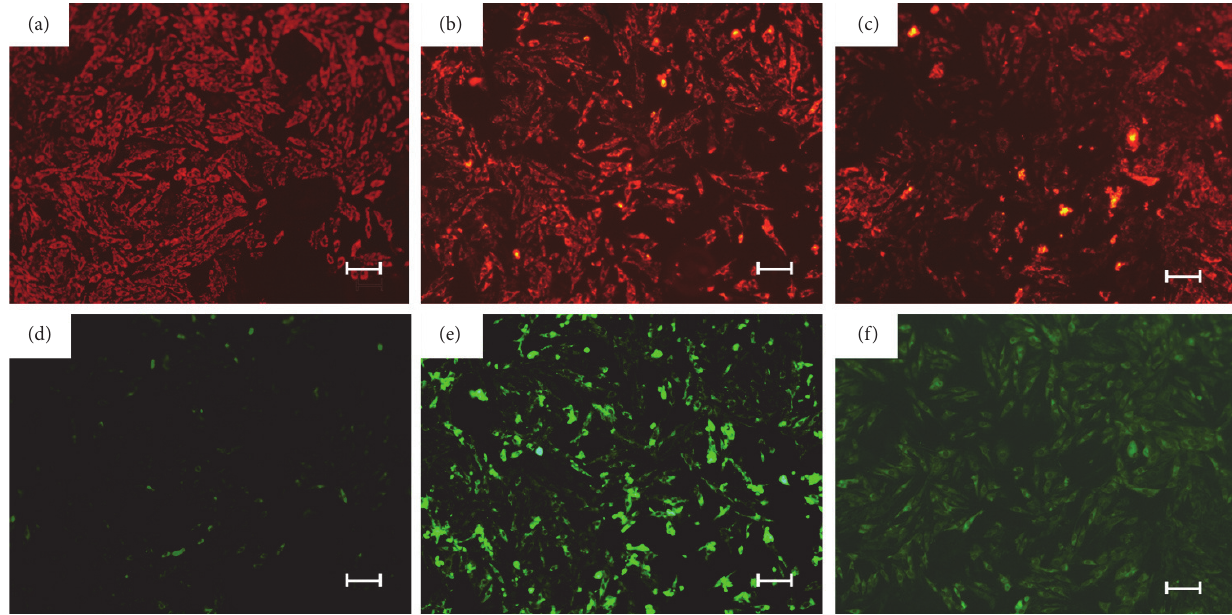
Figure 6: HucMSCs-exosomes inhibit H 2 O 2 -induced mitochondria activation. H9C2(2-1) were pretreated with hucMSCs-exosomes (800 𝜇 g/mL) for 24 hours, followed by exposure to H 2 O 2 (300 𝜇 M) for 24 hours. The cells were subjected to JC-1 staining for 15min. The signals were observed under fluorescence microscope. Control (a, d); H 2 O 2 (b, e); and hucMSCs-exosomes (c, f).